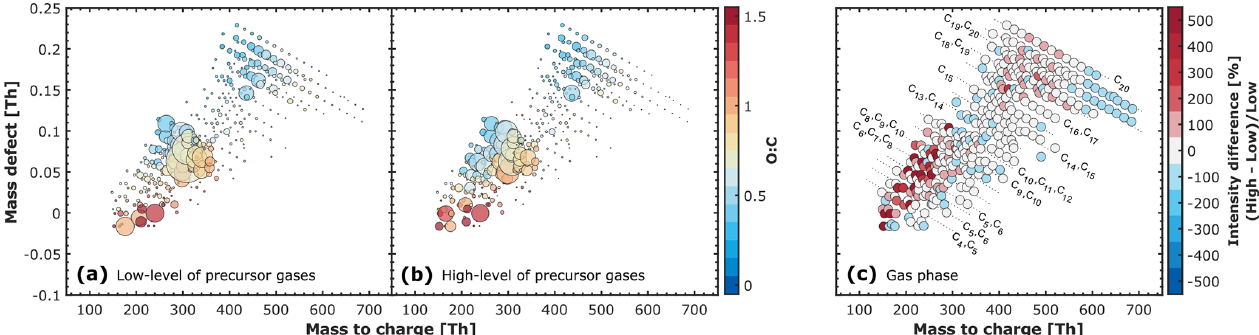
Figure 7. Mass defect plots of gas phase for two different systems and the normalized difference between them. Gas phase is measured with a nitrate CI-APi-TOF mass spectrometer. (a) α -Pinene oxidation products at − 10 ◦ C and 90% RH at low level of precursor gases and (b) α -pinene oxidation products at − 10 ◦ C and 80% RH at high level of precursor gases. α -pinene was 0.2–0.8ppbv and ozone ∼ 40– 50ppbv in (a) , and α -pinene was 2–3ppbv and ozone ∼ 100ppbv in (b) . The symbol sizes and colors in (a) and (b) represent the intensities normalized by the total signal in each system. (c) The difference between the normalized signals shown in (a) and (b) is represented by the color scale.